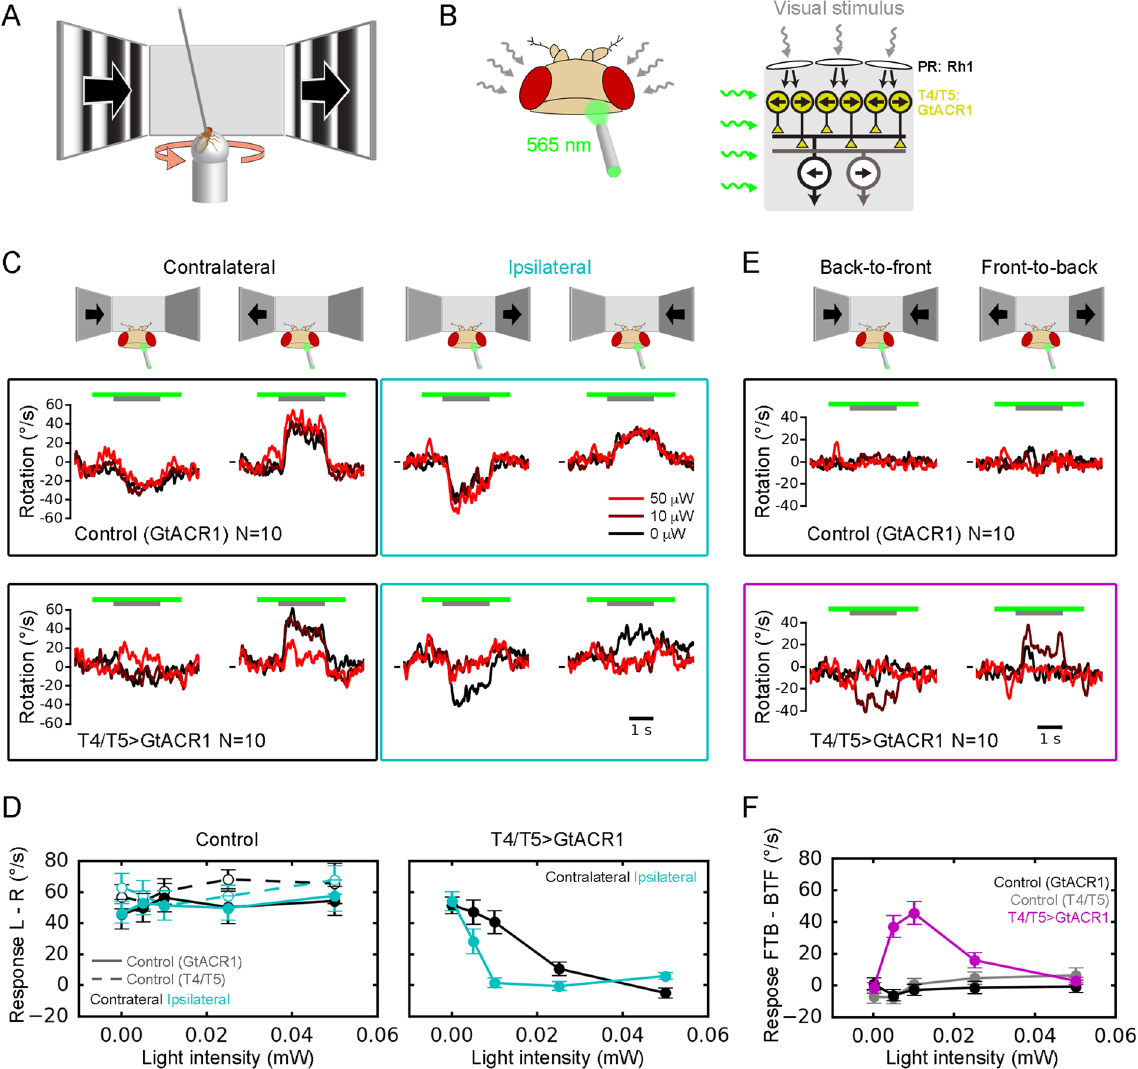
Figure 4. Using GtACR1 for optogenetic silencing of visual motion signals underlying the optomotor response. ( A ) Schematic illustrating the behavioral optomotor assay. A tethered fly is walking on an air-suspended ball whose rotation is measured, allowing to obtain fly turning responses to visual motion. ( B ) To optogenetically silence visual neurons expressing GtACR1, light is focused onto a small spot (0.12 mm 2 ) on the back of the fly head. ( C ) Fly turning responses (averaged across 20 trials and 10 flies) to visual motion towards left and right, presented either on the same (ipsilateral) or contralateral side of optogenetic illumination. Response traces for three illumination conditions are overlaid (0, 10 and 50 μ W). Control flies (upper row) show no discernible changes in optomotor behavior due to illumination. In contrast, T4/T5 > GtACR1 flies display markedly reduced optomotor turning upon illumination (lower row), particularly in combination with ipsilateral visual stimulation (two plots on the right). The short horizontal lines in front of traces indicate zero turning. ( D ) Quantification of experiment presented in C , with an additional control (T4/T5 driver only, i.e without expression) and two additional optogenetic light intensities. Baseline-subtracted responses to left- and right-ward motion were combined (L–R) separately for ipsi- and contralateral stimulation. ( E ) Experiment as in C but with simultaneous visual motion in opposite directions on left and right side (back-to-front, shown on the left; front-to-back, shown on the right). Control flies do not display turning on average in any condition. T4/T5 > GtACR1 flies respond with turning to both visual stimuli when combined with illumination of intermediate intensities, in agreement with GtACR1-mediated unilateral motion blindness. The short horizontal lines in front of traces indicate zero turning. ( F ) Quantification of experiment presented in E , with an additional control (T4/T5 driver only, i.e without expression) and two additional optogenetic light intensities. Baseline-subtracted responses to front-to-back and back-to-front were combined (FTB - BTF). Data in D and F represent the mean ± standard error of the